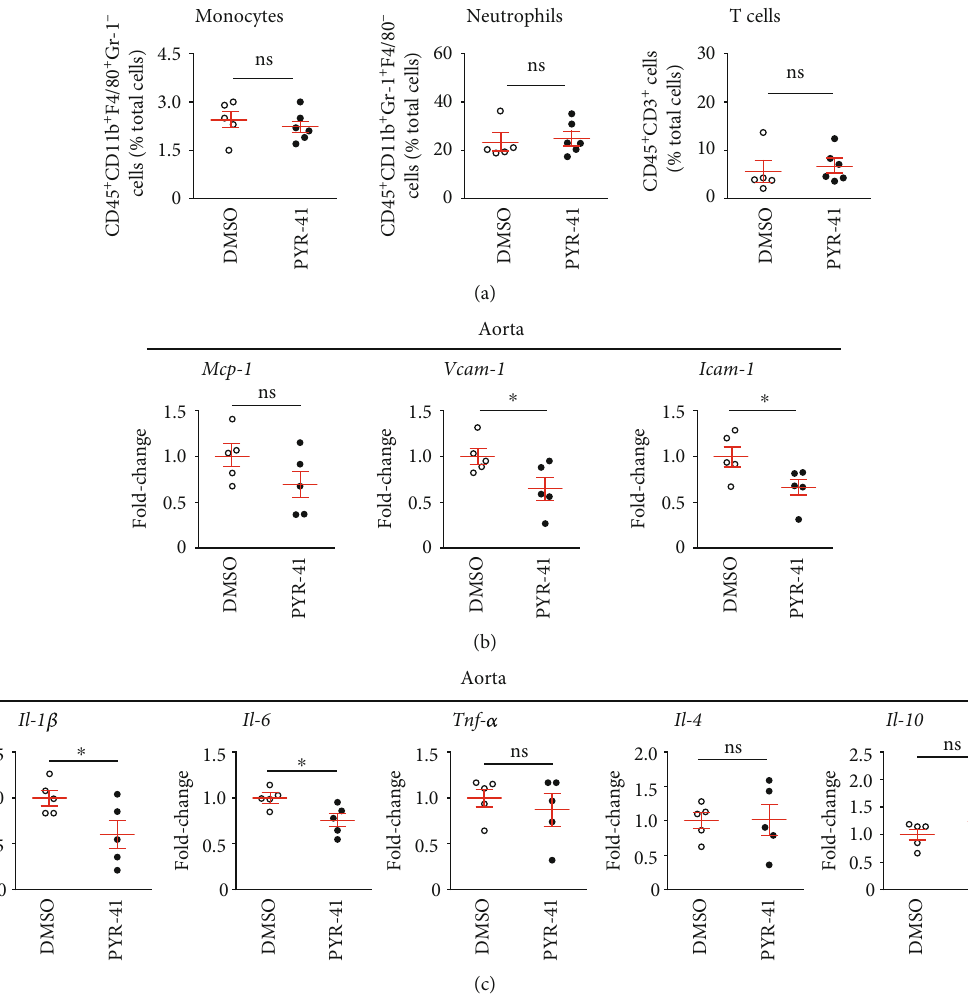
Figure 4: Inhibition of UBA1 decreased proin fl ammatory cytokine levels in diet-induced atherosclerosis in Apoe-/- mice. (a) Flow cytometry analysis of circulating monocytes, neutrophils, and T cells. (b) Quantitative real-time PCR analysis of aortic expression of cytokines associated with monocyte recruitment ( Mcp-1 , Vcam-1 , and Icam-1 ). (c) Quantitative real-time PCR analysis of aortic expression of macrophage-derived proin fl ammatory ( Il-1 β , Il-6 , and Tnf α ) and anti-in fl ammatory ( Il-4 and Il-10 ) cytokines. n = 5 ‐ 6 per group; ∗ : < 0.05; ns: not signi fi